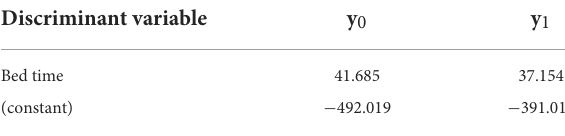
TABLE 4 Fisher function coefficients of 3–5 months age group.